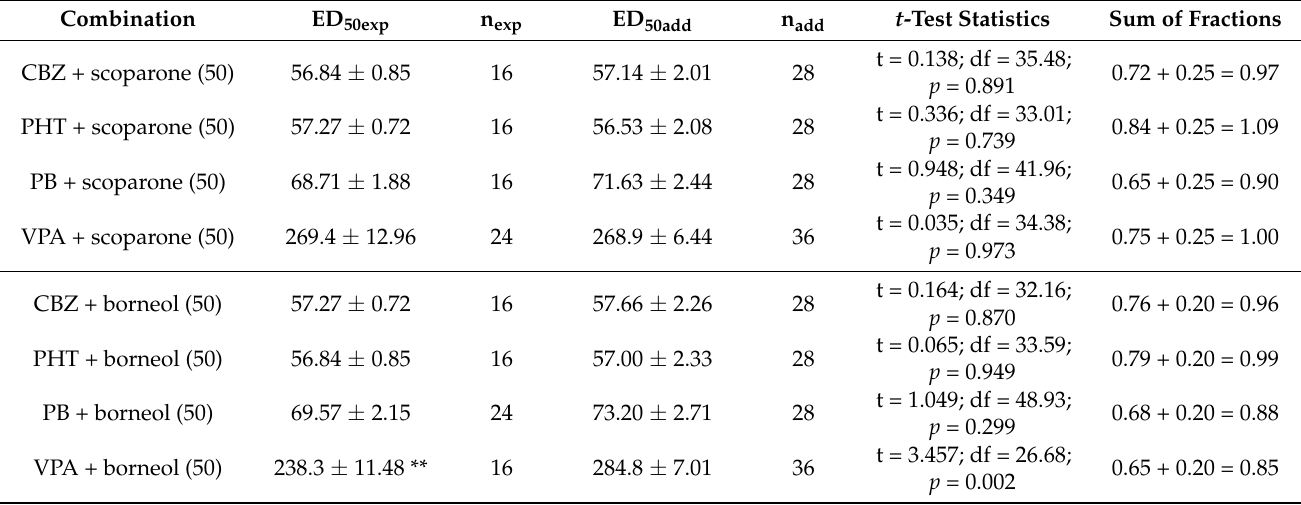
Table 2. Isobolographic transformation of the anticonvulsant potency of scoparone, borneol and four classic antiseizure medications in the mouse MES